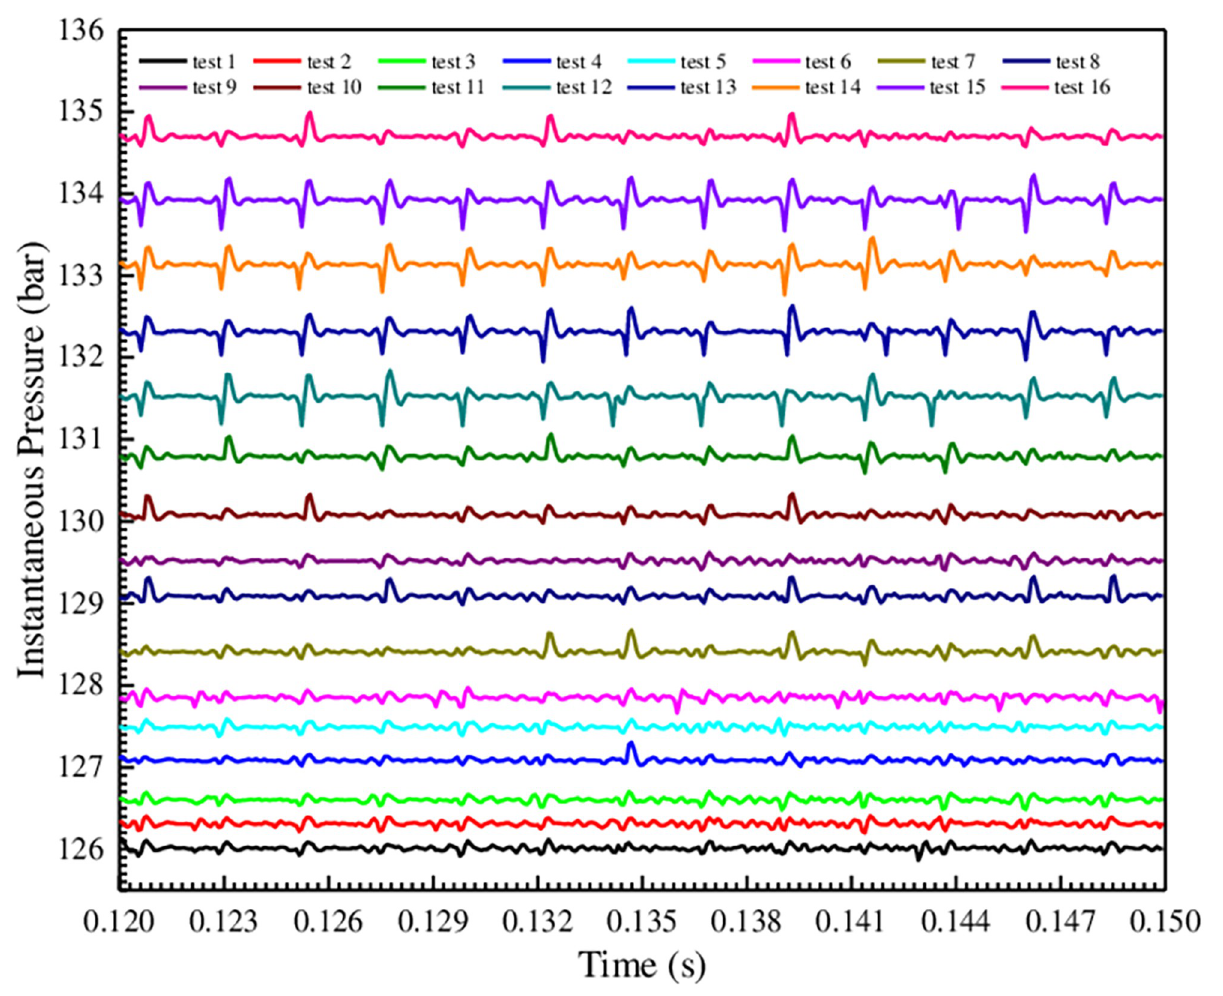
Fig 12. Comparison of instantaneous outlet pressure curves under different test